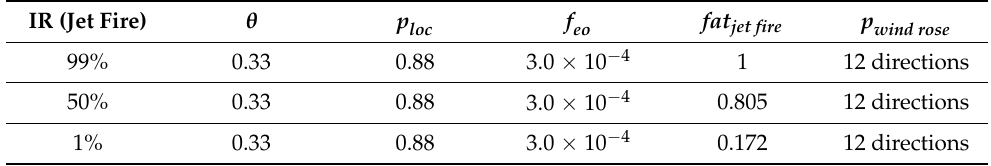
Table 7. Calculation of IR for different fatality